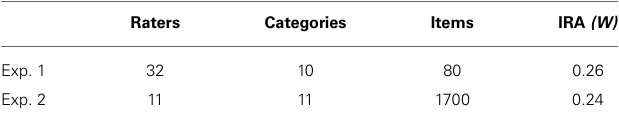
Table 4 | Inter-rater agreement in two experiments according to Kendall’s coefficient of concordance W .